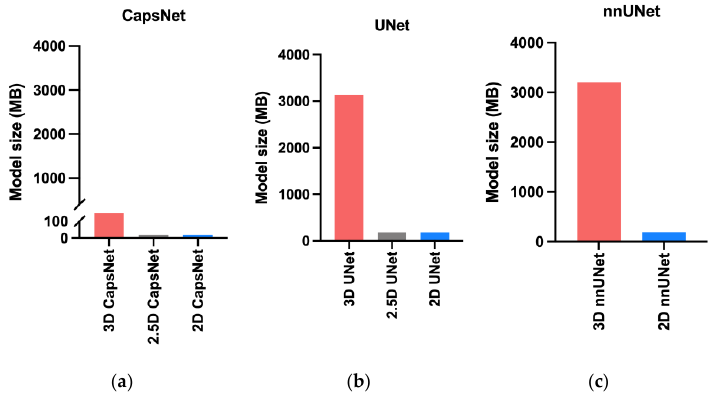
Figure 5. Comparing the memory required by the 3D, 2.5D, and 2D approaches. The bars represent the computational memory required to accommodate the total size of each model, including the parameters plus the cumulative size of the forward- and backward-pass feature volumes. Within each auto-segmentation model including the CapsNet ( a ), UNet ( b ), and nnUNet ( c ), the 3D approach required 20 times more computational memory compared to the 2.5D or 2D